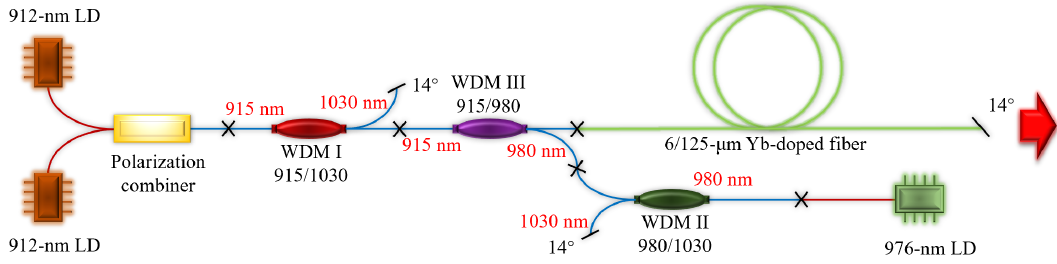
Figure 1. The experimental setup.